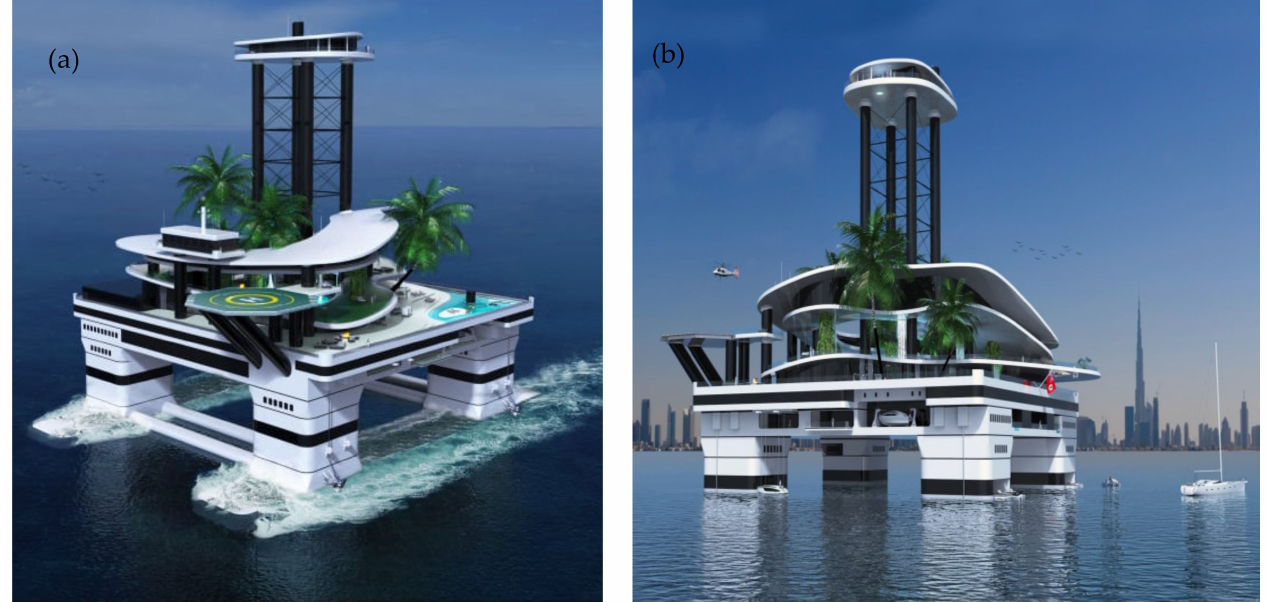
Figure 21. Views of the Mini Island Semisubmersible—Migaloo’s Kokomo Ailand, showing ( a ) iso- metric view and ( b ) front view (Adapted/Reused with permission from Christian Gumpold, CEO of Migaloo Private Submersible Yachts and Migaloo Submarines. Courtesy: